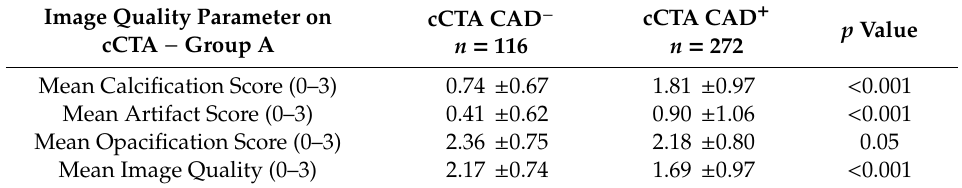
Table 3. Qualitative imaging parameters of cCTA per patient in Group A.